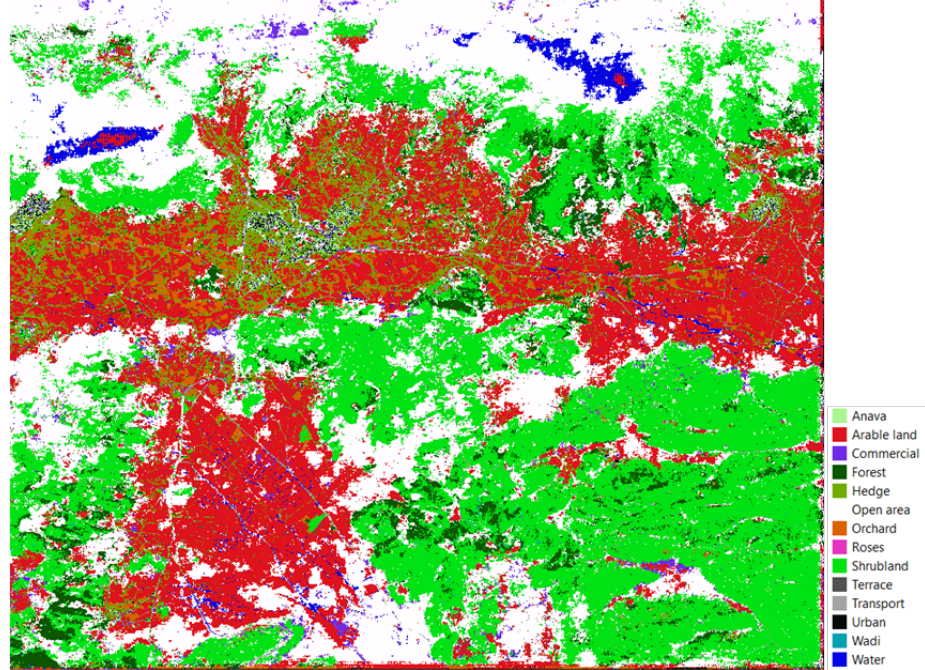
Figure 11. Predicted LULC map for the entire 1981 Sagalassos orthophoto based on the 2015 training data (MiniFrance-hist pretrained + SAG2015-hist